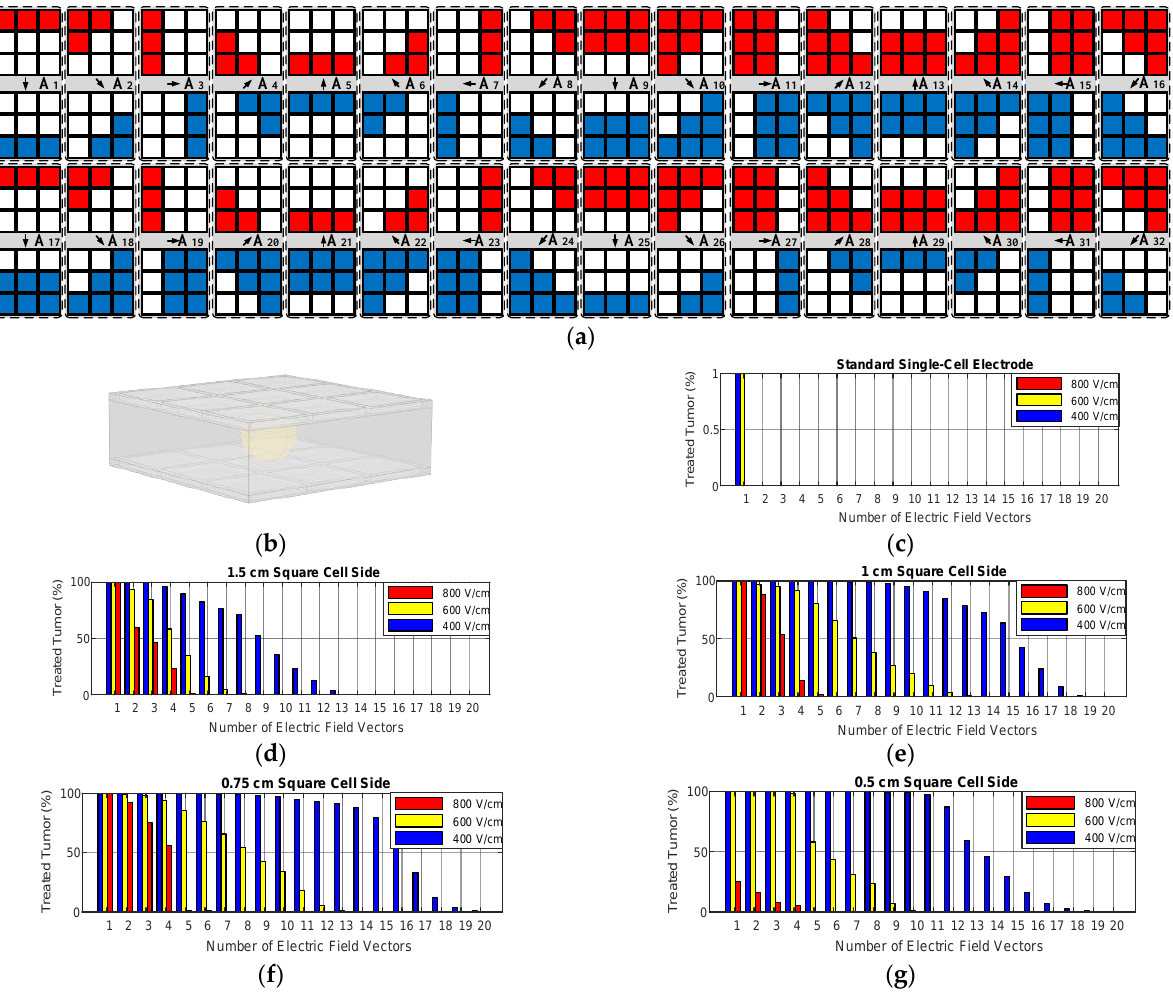
Figure 11. Square electrode optimization results: ( a ) 32 CSs applied, and ( b ) geometry of the square matrix parallel-plate electrode (MPPE) with tumor. Bar graphs with the percentage of tumor treated: standard electrode ( c ), 1.5 cm square electrode cell side ( d ), 1 cm square electrode cell side ( e ), 0.75 cm square electrode cell side ( f ) and 0.5 cm square electrode cell side ( g ).